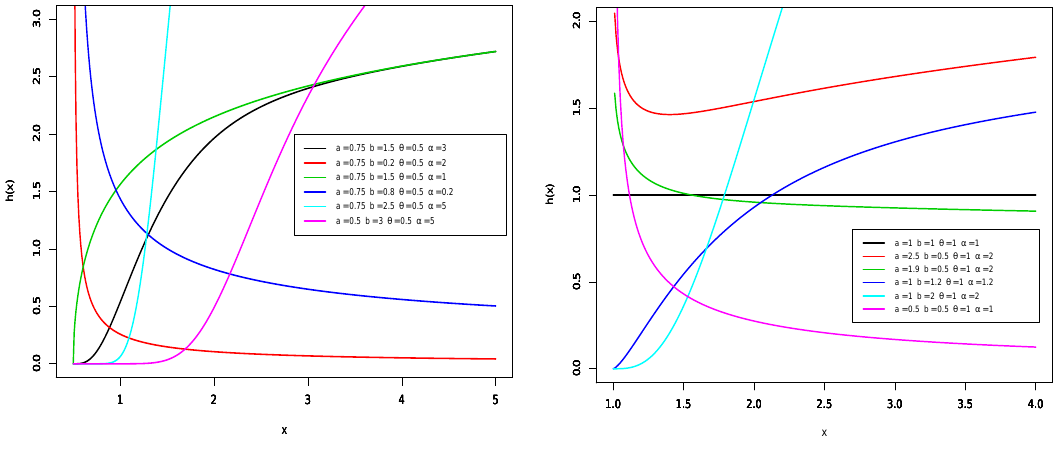
Fig. 2. Hazard rate function of EWP distribution for selected values of the